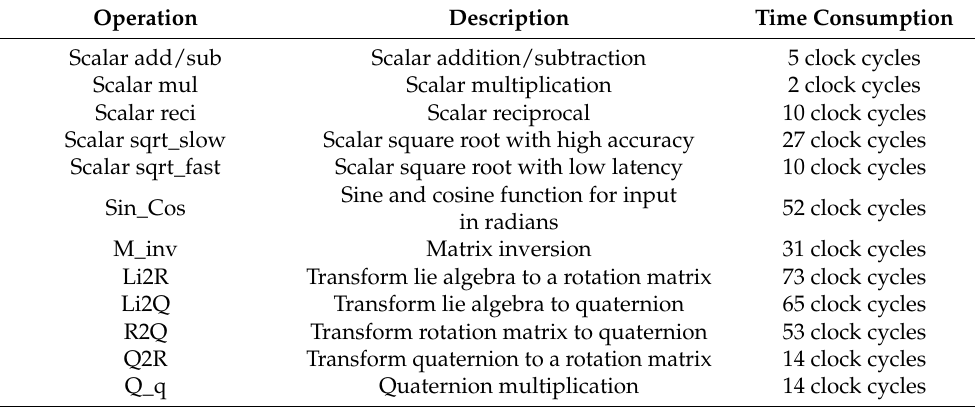
Table 1. Supported operations by the accelerated